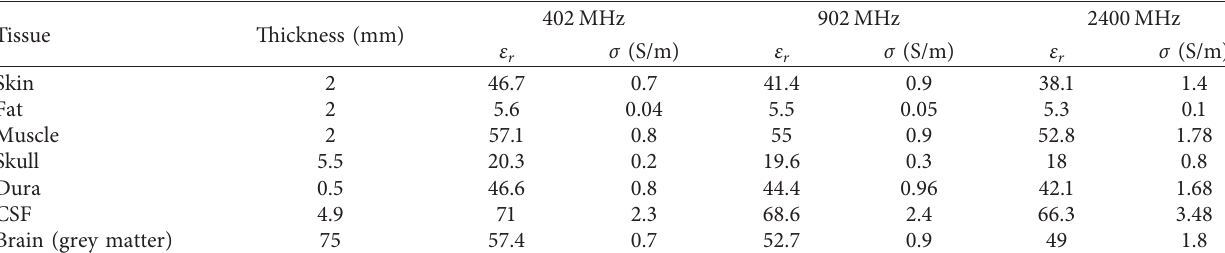
Figure 3: The 7-layer human head model used for the proposed implanted PIFA. Table 1: Electrical properties of the 7-layer head